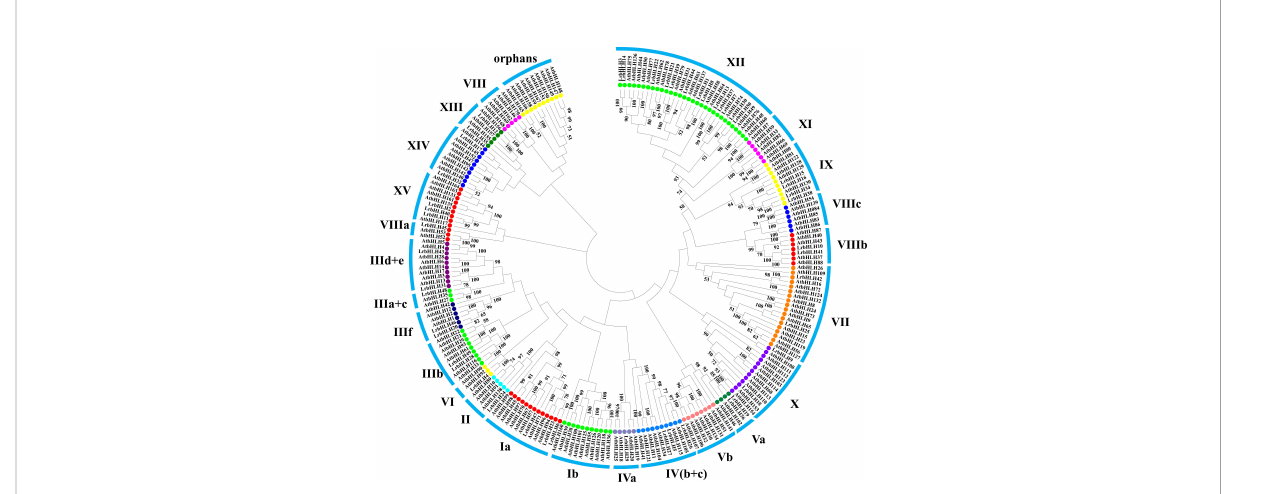
FIGURE 1 The phylogenetic analysis of L. radiata and Arabidopsis bHLH proteins. The neighbor-joining method was utilized to generate the phylogenetic tree relying on the bHLH domains alignment. These numbers are computed using 1000 bootstrap replicates to verify reliability. The replicate trees percentages over 50 are presented on branches. The tree shows the 25 subfamilies marked with blue font on a colored